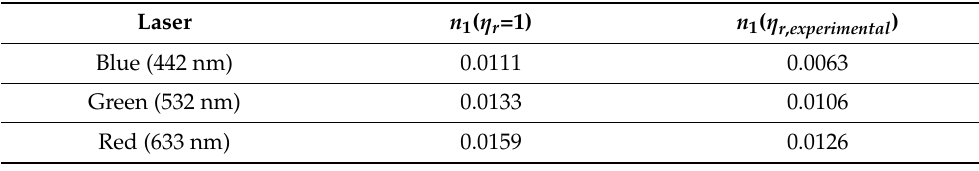
Table 2. Maximum modulation values of the refractive index for an ideal efficiency of 100% and that obtained experimentally.